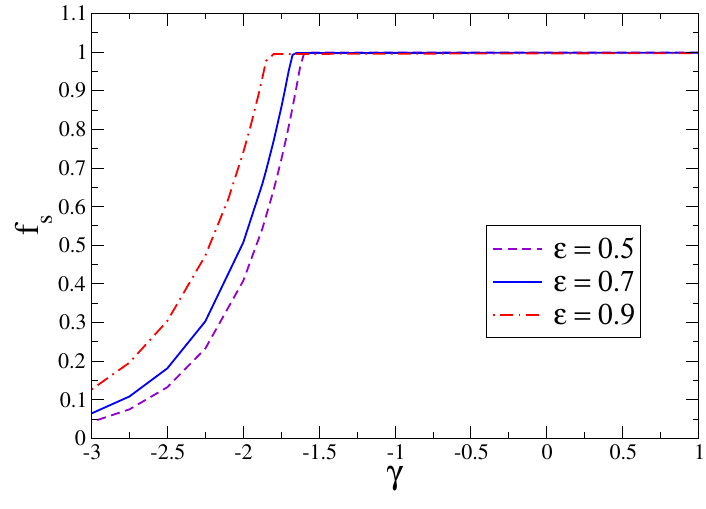
Figure 4: Superfluid fraction f of the BEC ground state in an ellipse as a function of s ( N − 1 ) / l 2 the adimensional interaction strength γ = 2 aa , where a is the length of ⊥ s the major semi-axis, a is the 3D s-wave scattering length and l ⊥ is the characteristic s length of the transverse harmonic confinement. The curves are obtained for three values of the eccentricity ε of the